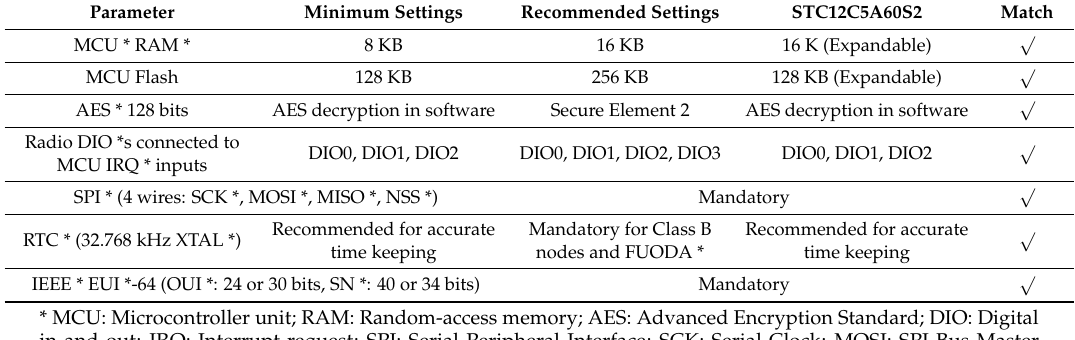
Table 6. Module MCU technical requirements for SX1278